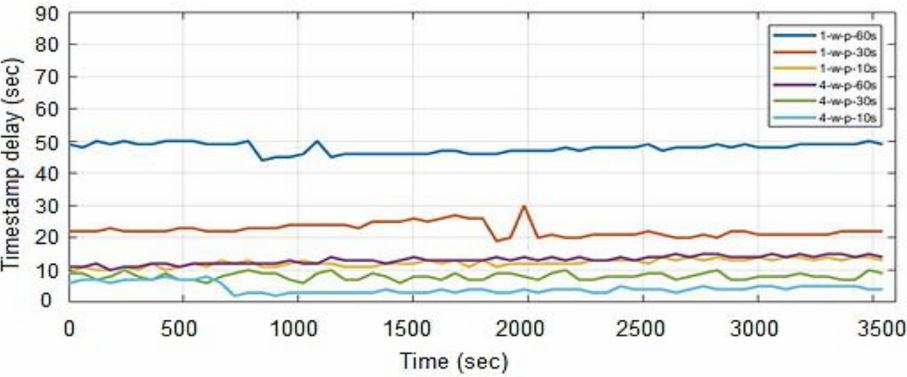
Figure 13. Timestamp delay in Gnocchi with one and four processing